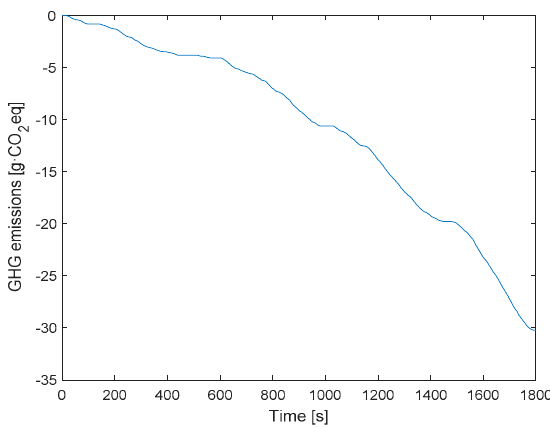
Figure 10. Power of regenerative suspension.